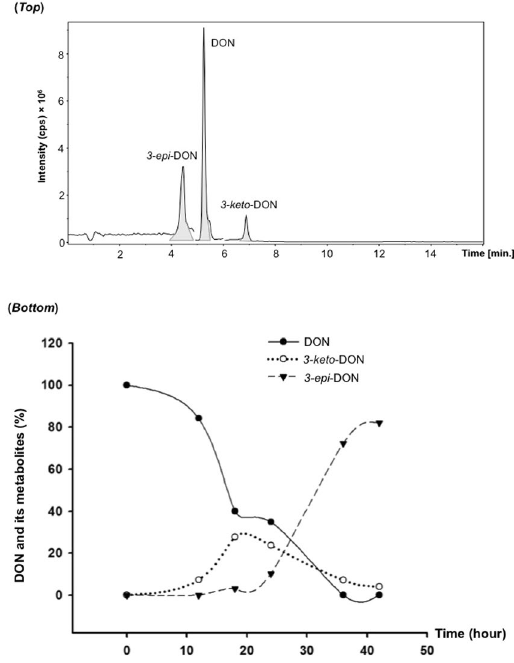
Figure 3. The chromatographic separation of DON, 3-keto- DON and 3-epi- DON by LC-MS/MS and DON epimerization dynamics in Devosia mutans 17-2-E-8 cultures growing in Corn Meal broth (CMB). ( Top ): The chromatographic analysis of DON, 3-keto- DON and 3-epi- DON using LC-MS/MS platform. The extracted ion chromatograms for transitions m/z 296.5 > 249.1 for DON as well as 3-epi -DON and m/z 294.9 > 247.1 for 3-keto- DON are shown. ( Bottom ): Both the disappearance of DON and the appearance/accumulation of 3-keto - DON and 3-epi -DON were monitored in D . mutans cultures up to 42 h as reported within the Materials and Methods